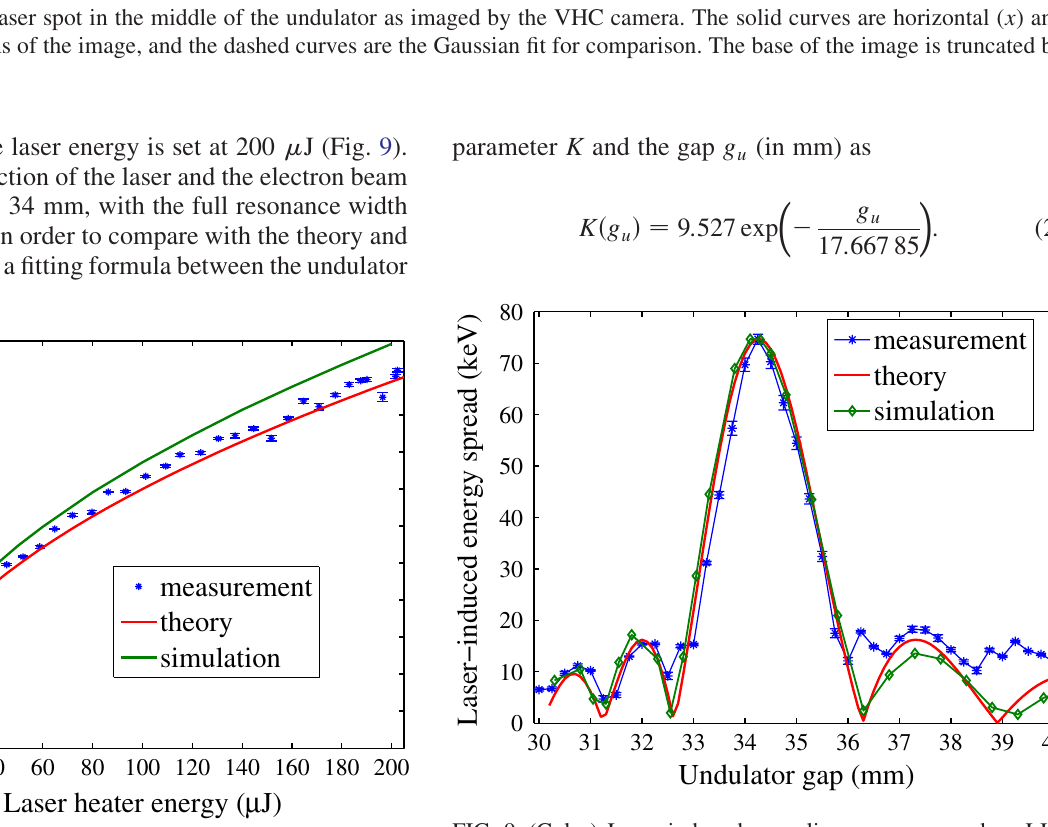
FIG. 8. (Color) Central slice rms energy spread vs LH energy.